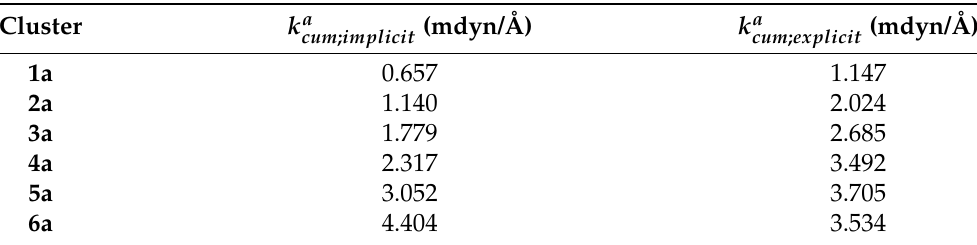
Table 5. Cumulative local mode force constants k a cum for the implicit and explicit solvation of [Ca(H 2 O) n ] 2+ (n = 1–6) ( 1a – 6a ), calculated at the ω B97X-D/6-311++G(d,p) level of theory, from the work of Delgado et al.